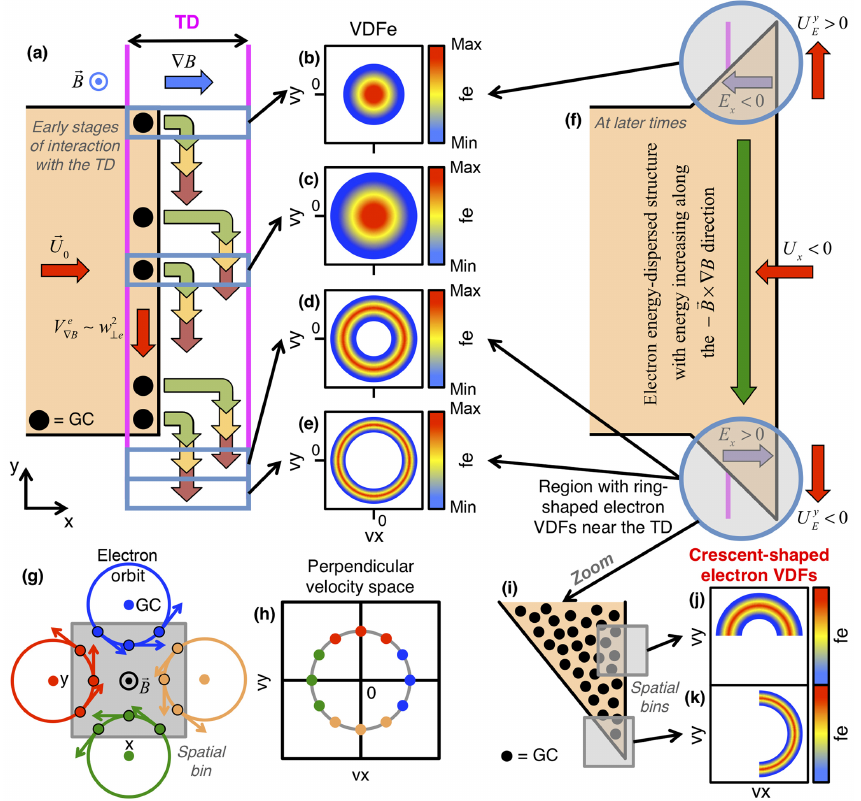
Figure 4. Panel (a) illustrates the phase A of plasma jet’s interaction with the magnetic discontinuity. The black dots indicate the guiding centres (GCs) of electrons localized at the front edge. The multiple groups of green–yellow–red arrows show the gradient-B drift displacement of the GCs proportional to the gyration energy (green corresponds to the lowest energy). The four blue boxes indicate the bins where the VDF is computed. The electron VDFs obtained for the upper edge bins ( b, c ) are gyrotropic and their phase density vanishes for large velocities; the VDFs obtained for the bottom edge bins (d, e) are ring-shaped. Panels (g) and (h) illustrate how the electrons with GCs outside a spatial bin contribute to different sectors of the VDF collected in the respective bin. The colours of the dots in panel (h) identify which particle shown in panel (g) contributes to that sector of the VDF. This effect corresponds to a remote sensing of the large Larmor radius electrons outside the bin. Panels (f) and (i) – (k) show how the remote sensing effect contributes to the formation of crescent-shaped VDFs in a configuration similar to the PIC